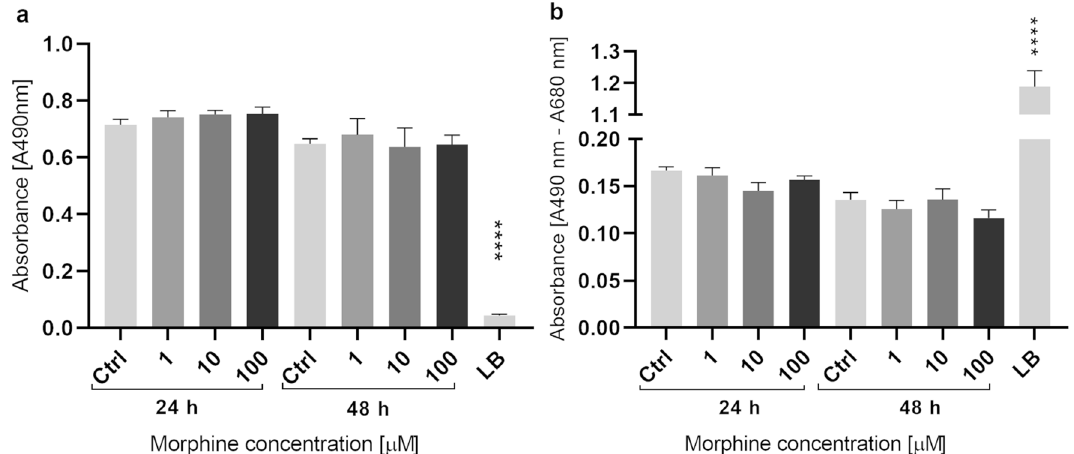
Figure 1. MTS proliferation and LDH cytotoxicity assay. MTS Proliferation Assay ( a ) and LDH Cytotoxicity Assay ( b ). The two time points and three concentrations of morphine treatment are represented for each assay. The y-axis corresponds to the formazan absorbance at 490 nm for MTS assay and to the difference in formazan absorbance at 490 nm and 680 nm for LDH assay. Data are represented as means ± standard deviation (SD) of six biological replicates. Statistical significance of each measure from treated cells toward the control culture was evaluated with a one-way ANOVA test. Significant p -values: **** p -value < 0.0001. Ctrl = control and LB = lysis